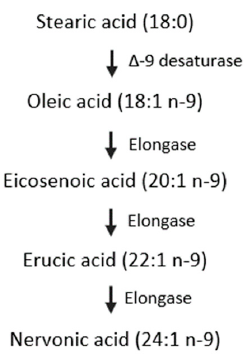
Figure 4. Hypothetical pathway for the synthesis of nervonic acid in infants.